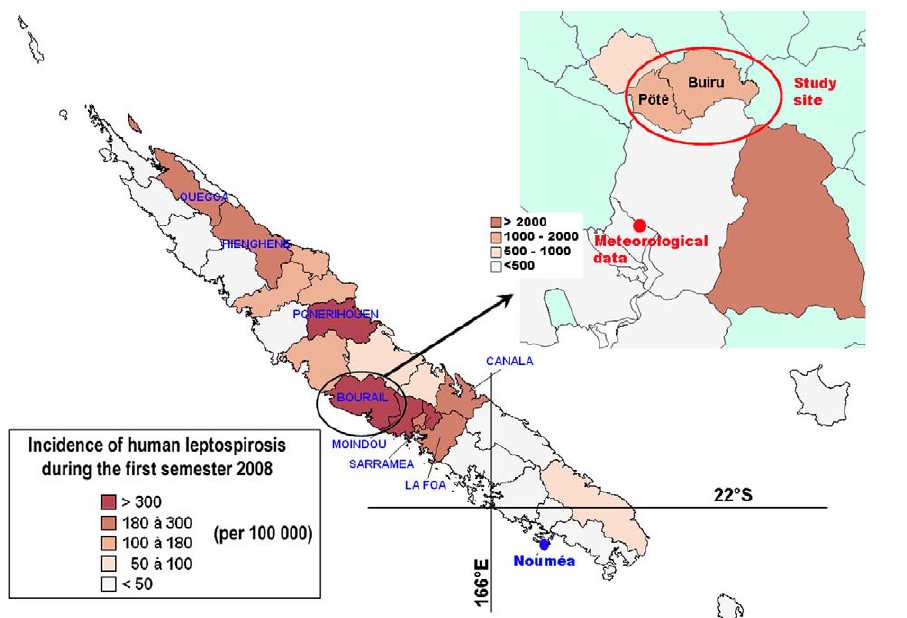
Figure 1. Hot spots of leptospirosis and identification of the study site and meteorological data collection point. (Map produced using PopGis, as described in the Methods section and demographic data from the Institut de la Statistique et des E´tudes E´conomiques, http://www.isee.